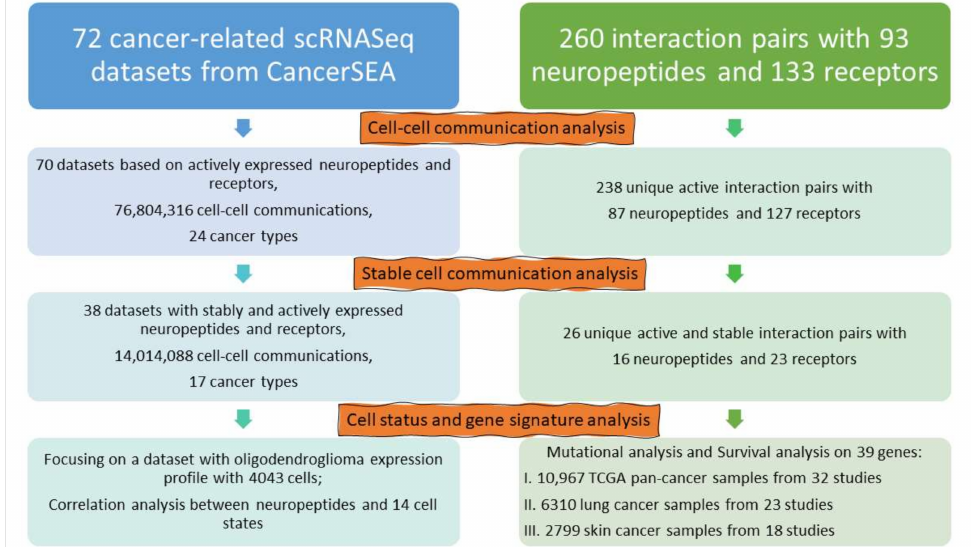
Figure 1. A diagram depicting the construction of a cell-to-cell communication network based on neuropeptide-receptor interactions. The results (orange) and step-by-step analyses ( left ) are organized depending on the datasets ( left ) and the number of neuropeptides ( right ). We identified actively expressed neuropeptides and receptors by cell-cell communication analysis. The stable cell communication analysis narrows down the neuropeptide and receptor connection based on the percentage of a certain neuropeptide-receptor among all possible cell-cell communications in a dataset. To cross-validate our prioritized genes, we performed an additional cell status and signature analysis using public cancer genomic